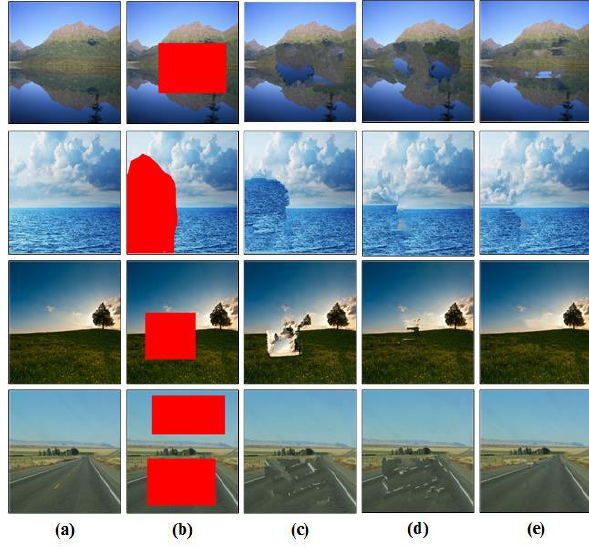
Figure 5. Recovering large missing regions, column (a) Original images, column (b) Masked images,